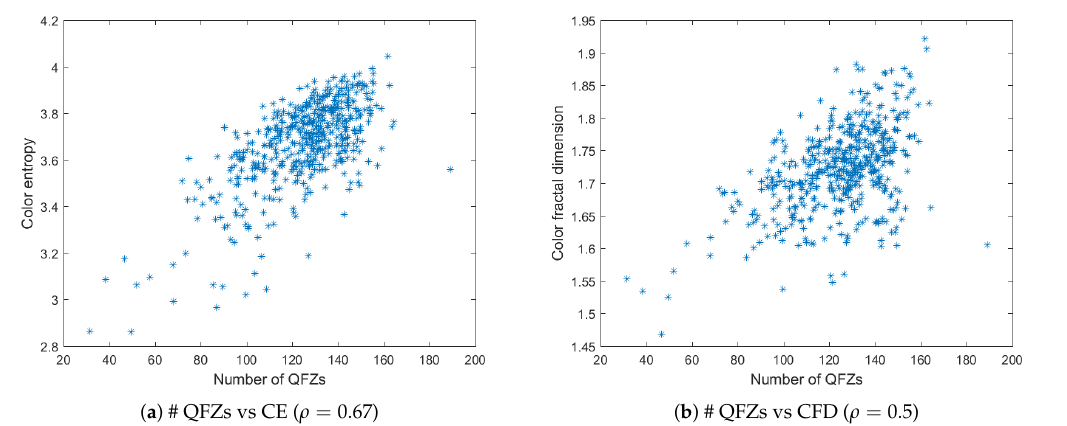
Figure 5. The number of QFZs versus color entropy ( a ) and color fractal dimension ( b ) for the BSDS500 data base. The corresponding Pearson correlation coefficient is given in brackets for each case.